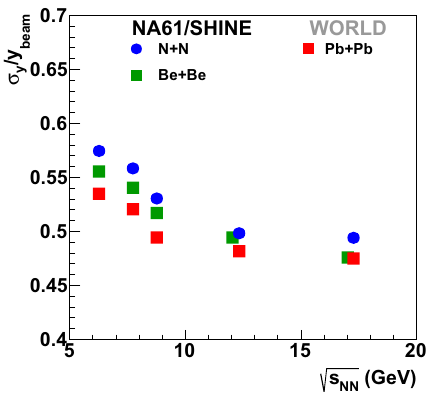
Fig. 17 Collision energy dependence of the ratio of the width σ y of the rapidity distribution to the beam rapidity y beam for central Be + Be and Pb + Pb collisions and inelastic N+N interactions